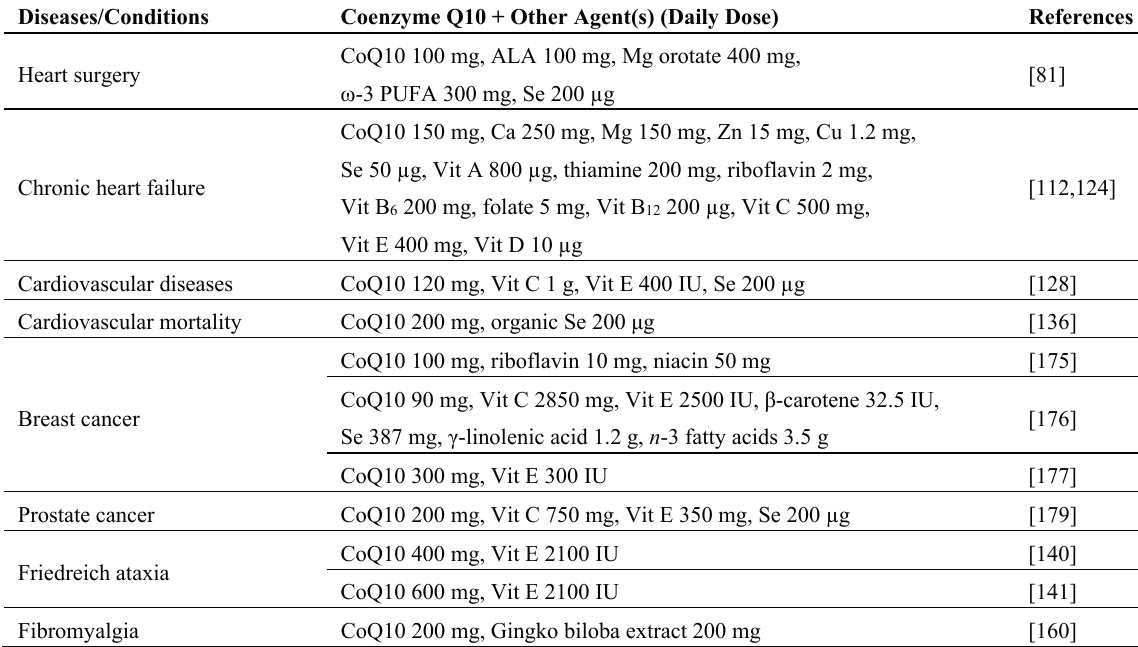
Table 6. Clinical studies utilizing mitochondrial nutrients and antioxidants and/or herbal compounds aimed at compensating OS/MDF-related pathogenetic